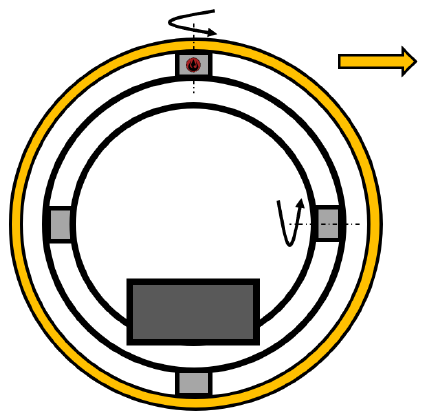
Figure 5. Principle sketch of a gimbal